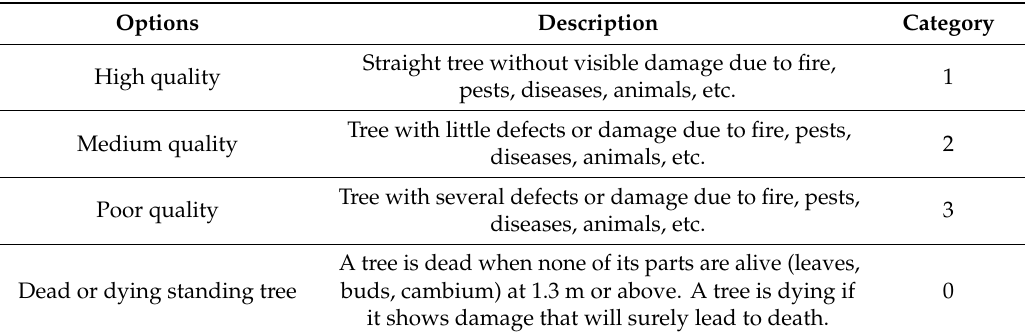
Table 2. Log grade